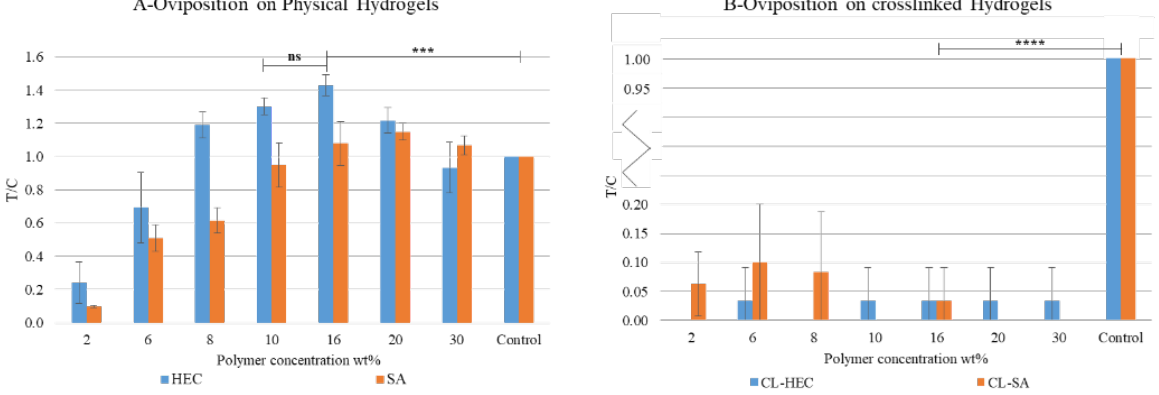
Figure 2. Absorbing paper was used as control. T/C is the ratio between eggs laid on the sample (T) and control (C). All the tests were carried at 25 °C and 80% relative humidity (RH) pH = 6.5; Salinity < 1%. Statistical analysis legend: p > 0.0123 = not significant (ns); p < 0.0002 = ***; p < 0.0001 =